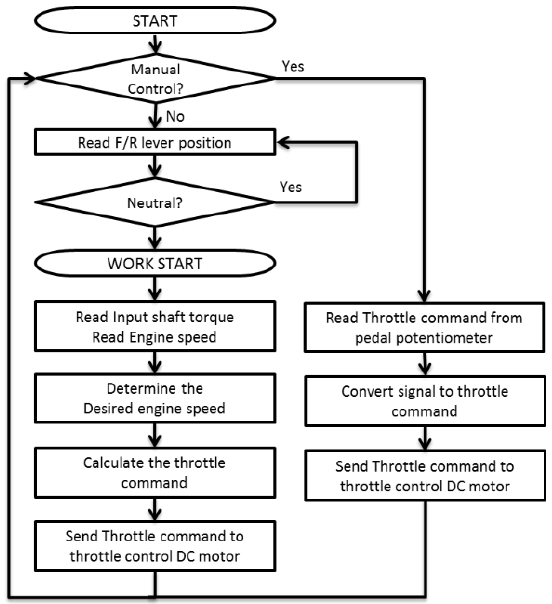
Figure 17. Flowchart of the control algorithm.